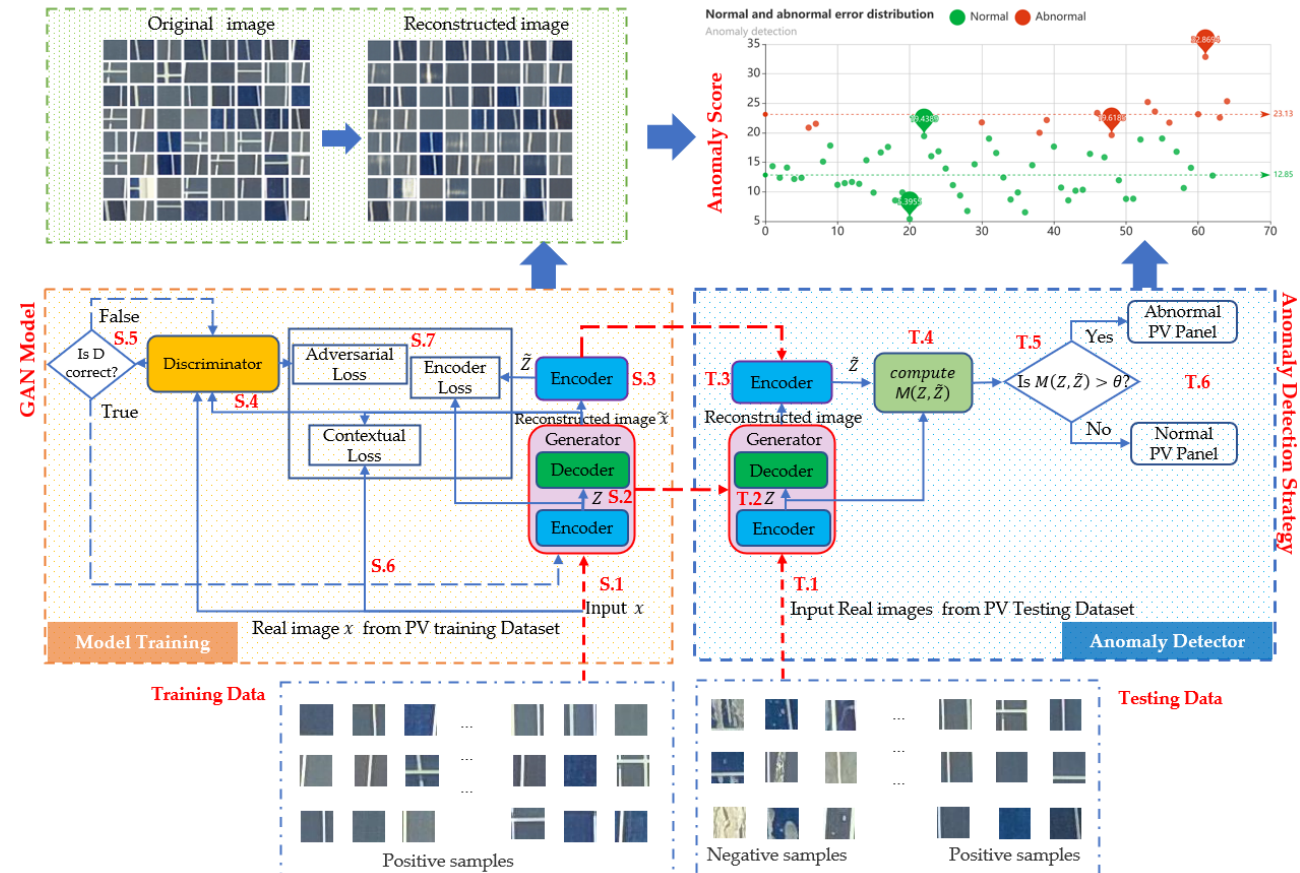
Figure 2. The integrated photovoltaic panel fault detection workflow of ppFDetector.